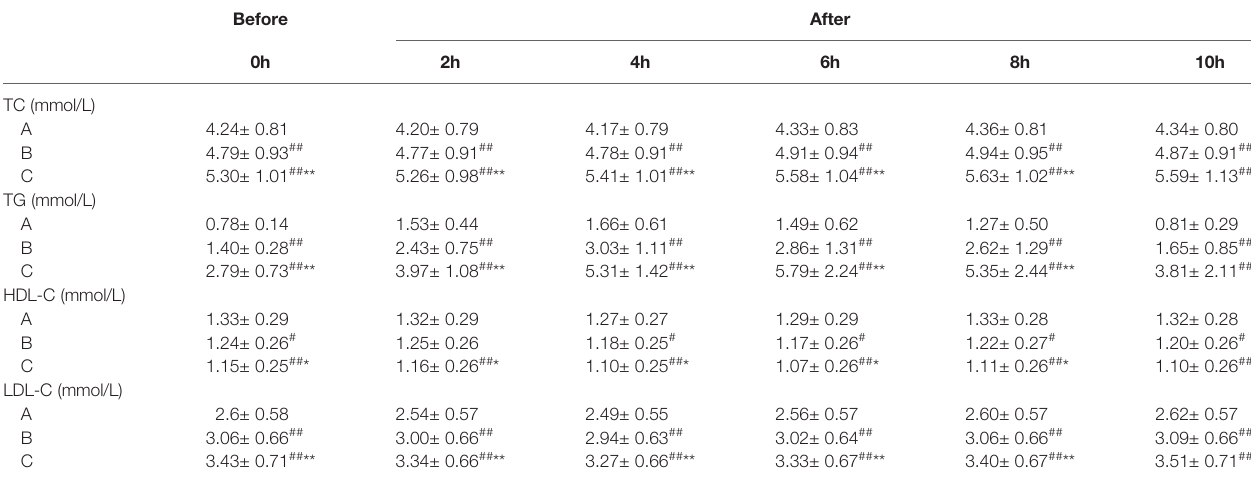
TABLE 2 | Postprandial plasma lipids concentration of groups with different FTG concentration.